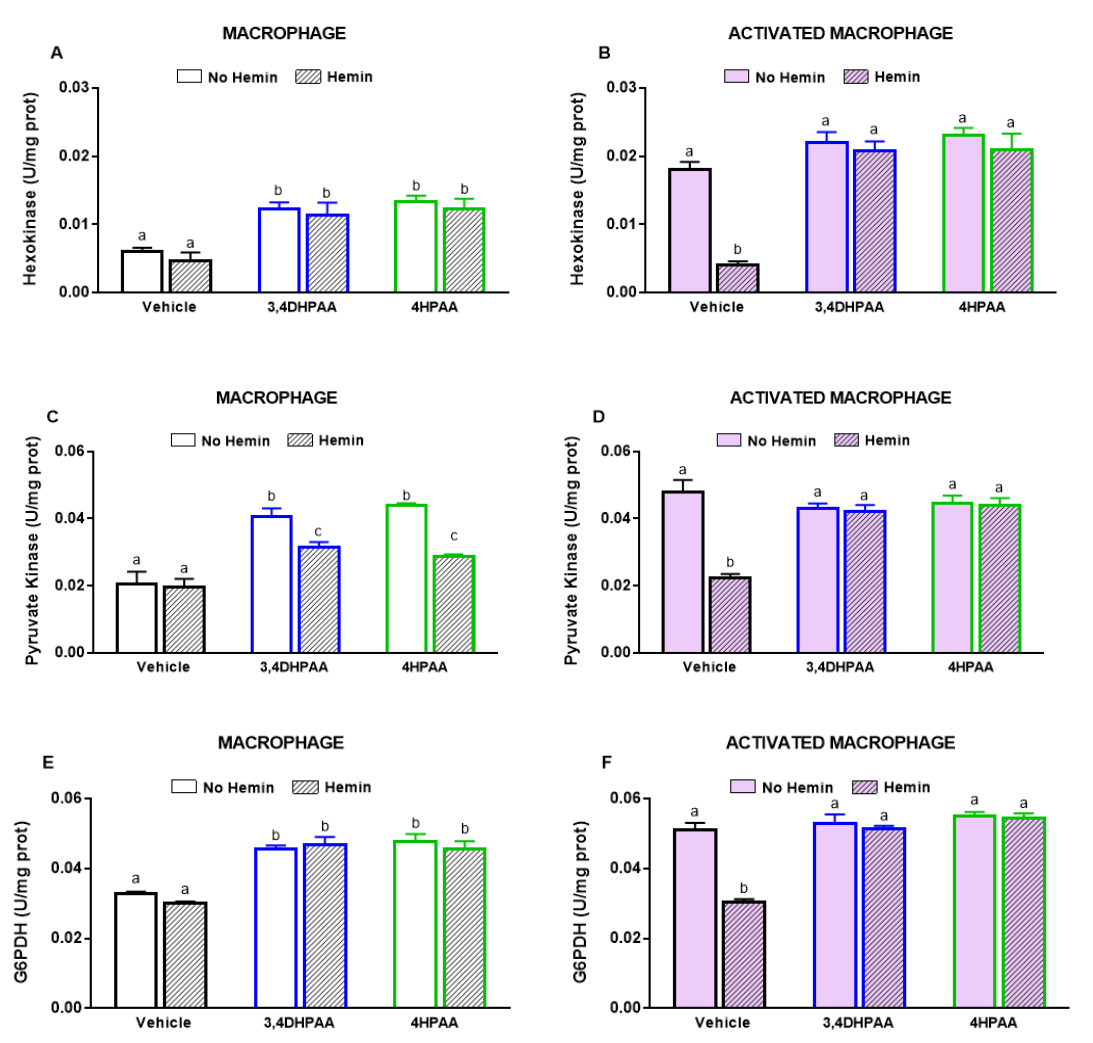
Figure 9. 3,4DHPAA and 4HPAA increase metabolic enzyme activities in macrophages and hemin reduces them in activated macrophages. Hexokinase activity in ( A ) macrophages and ( B ) activated macrophages; pyruvate kinase activity in ( C ) macrophages and ( D ) activated macrophages; and glucose-6-phosphate dehydrogenase activity in ( E ) macrophages and ( F ) activated macrophages. Enzyme activities were measured in macrophages incubated with 10 µ M 3,4DHPAA or 10 µ M 4HPAA, in the presence or absence of 10 µ M hemin for 72 h. Values with different superscript letters (a, b and c) indicate significant differences ( p < 0.05) between groups. For all bars with the same letter, the difference between the means is not statistically significant. 3,4DHPAA, 3,4-dihydroxyphenylacetic acid; 4HPAA, 4-hydroxyphenylacetic acid; G6PDH, glucose-6-phosphate dehydrogenase.